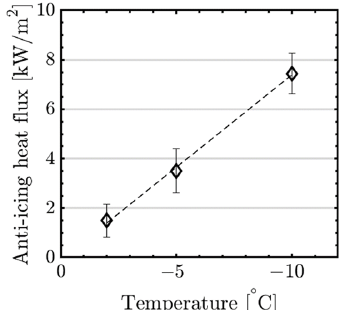
Figure 9. Minimum required heat fluxes for anti-icing at different temperatures.